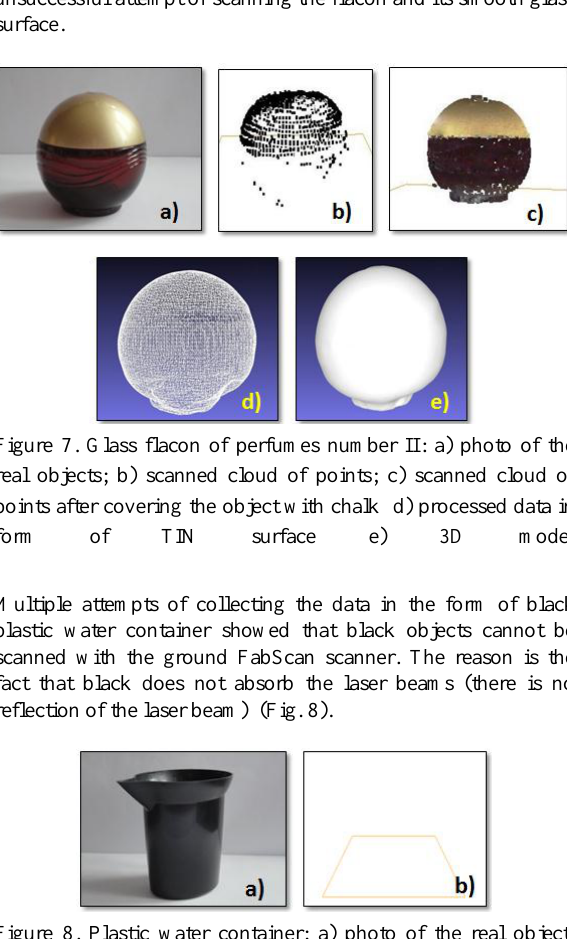
Figure 8. Plastic water container: a) photo of the real object; b) unsuccessful attempt of data